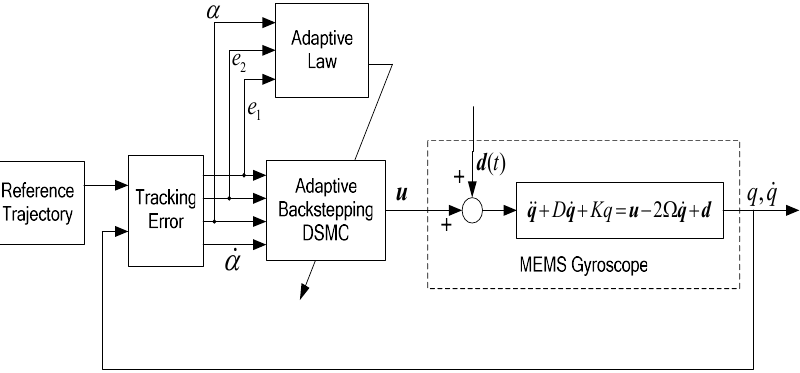
Figure 2. Block diagram of an indirect adaptive dynamic sliding mode controller (DSMC) based on the backstepping method.